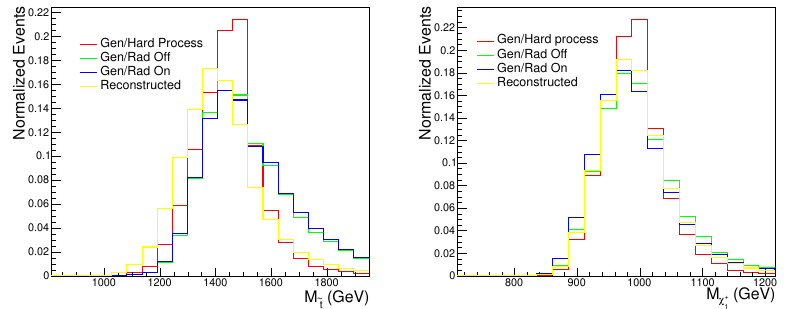
Figure 12 . The projected M ˜t (left) and M (right) for both generated and reconstructed level. x + 1 The generated level is shown for the case the hard process partons are used as input, as well as for generated leptons and jets after hadronization, when the initial/final state radiation is switched Off and On. The events have been generated for M ˜t = 1500 GeV, M = 1000 GeV and M ˜ ν = 800 GeV. x + 1